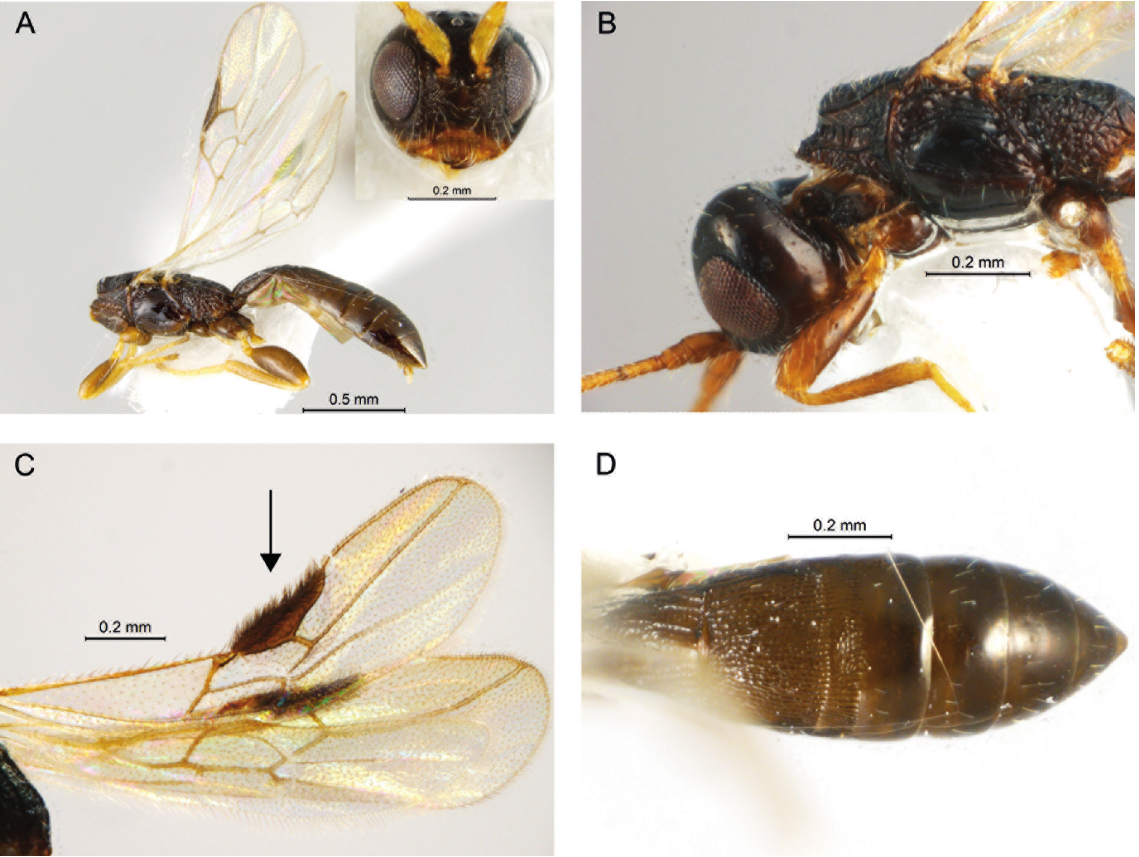
Fig. 7. Hecabolus mexicanus Zaldívar-Riverón & Belokobylskij, 2009, ♂ (CNIN-IBUNAM). A . Habitus, lateral view; inset: head, frontal view. B . Mesosoma, lateral view. C . Fore wings showing pterostigma with dense dark setae (arrow). D . Metasoma, dorsal